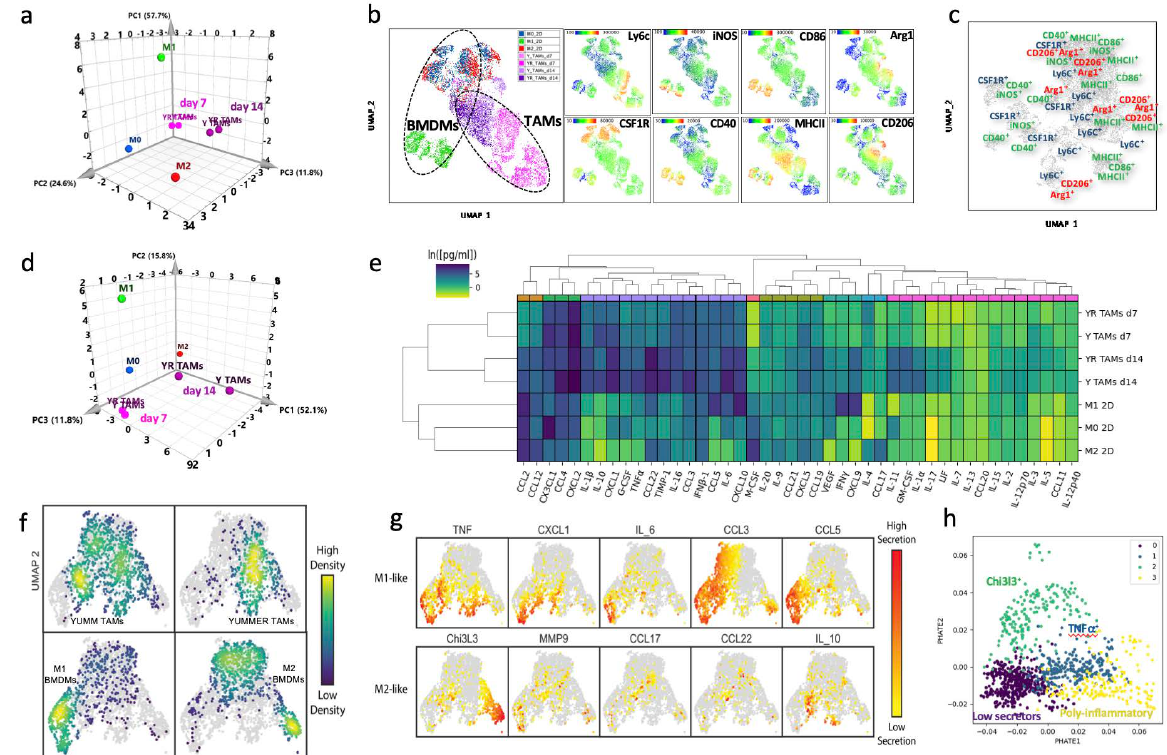
Figure 1. Characterization of the phenotype and functional profile of melanoma TAMs. ( a ) Phenotypical profile of melanoma TAMs. Principal component analysis (PCA) of the phenotype of in vitro stimulated BMDMs compared to TAMs from YUMM and YUMMER early (day 7) and late (day 14) tumors. This phenotypical characterization was assessed by flow cytometry using a panel of 10 markers and then combining the percentage and MFI of those parameters for the PCA analysis. For BMDMs n = 5, TAMs n = 4/5. ( b ) UMAP plots containing representative FACS single-cell data from a. Left, sample annotation. Right, detailed panels with heatmaps showing the expression of different markers used for analysis. ( c ) UMAP visualization with superimposed annotation of markers expressed in different regions of the phenotypic space in YUMM d14 tumors. ( d ) Functional profile of melanoma TAMs. PCA of the bulk secretion of in vitro stimulated BMDMs compared to TAMs from YUMM and YUMMER early and late tumors. ( e ) Hierarchical clustering analysis of the secretion profile of Y and YR TAMs at early and late timepoints compared to BMDM reference polarized states. ( f ) UMAP visualization of single-cell secretion profiles combining Y and YR TAMs with in vitro polarized BMDMs into M1 or M2. ( g ) Detail of the protein secretion associated with and M1- or M2-like function and distribution between conditions. ( h ) Annotation of the TAM functional clusters from YUMM and YUMMER tumors, in the PHATE plots, showing the generation of a pro-inflammatory axis on the first component and a Chi3l3 immunosuppressive axis on the second